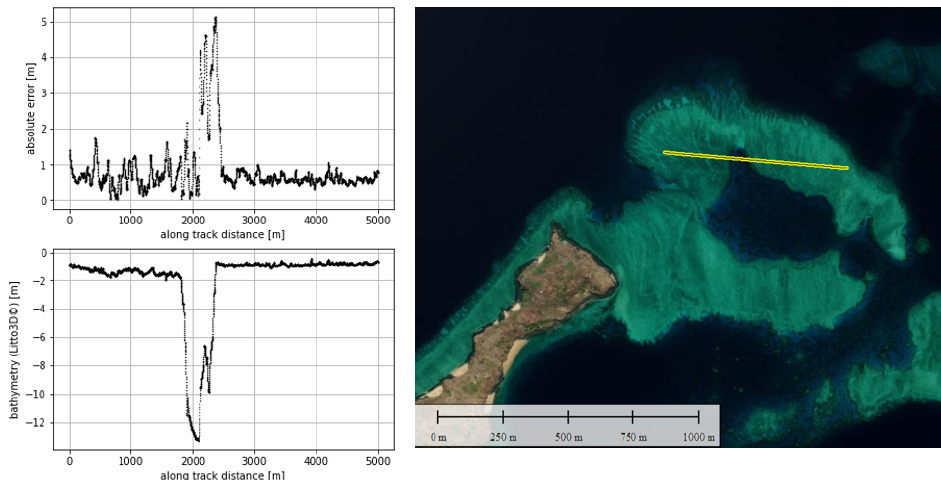
Figure A2. Evolution of the absolute error with depth on a transect along the ICESat-2 ground track.